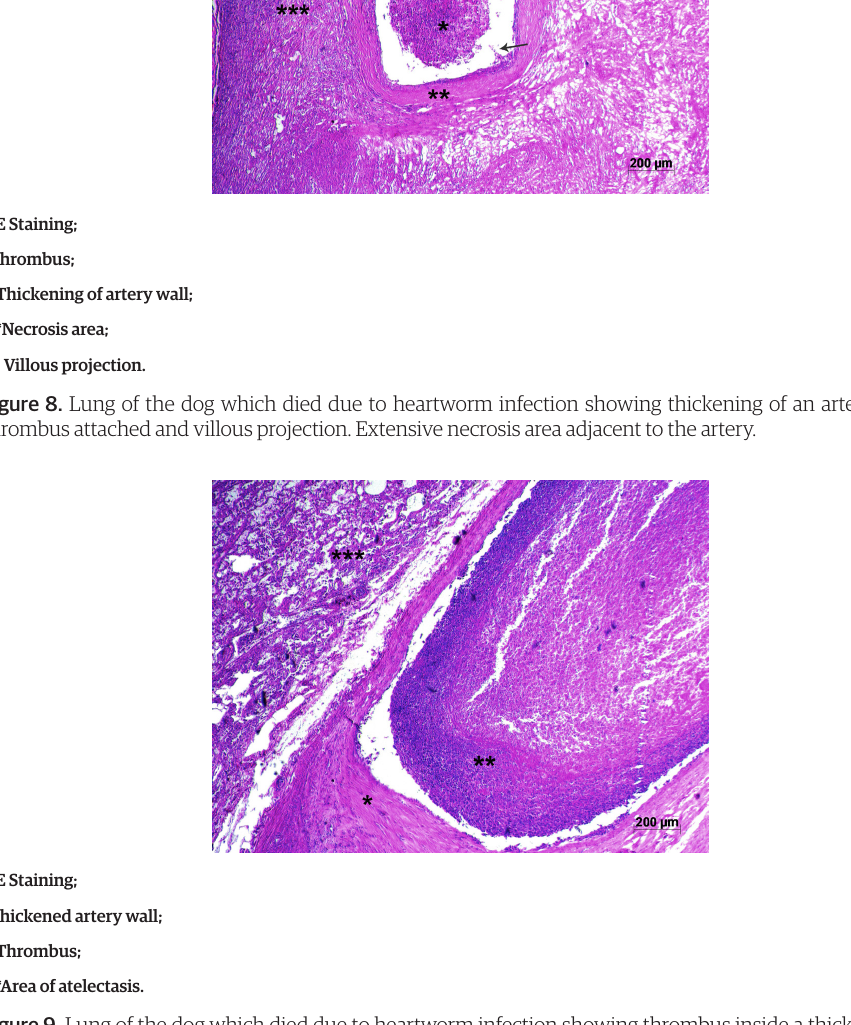
Figure 9. Lung of the dog which died due to heartworm infection showing thrombus inside a thickened wall artery. Extensive atelectasis area in the parenchyma adjacent to the